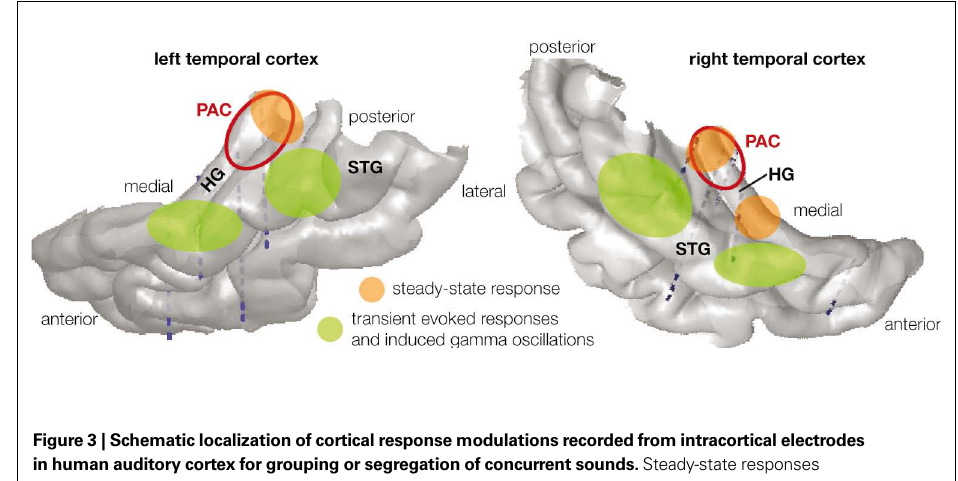
Figure 3 | Schematic localization of cortical response modulations recorded from intracortical electrodes in human auditory cortex for grouping or segregation of concurrent sounds. Steady-state responses were found larger when one sound rather than two was perceived in Heschl’s gyri. Transient evoked responses and induced gamma oscillations were found larger when one sound rather than two was perceived in secondary auditory areas in the superior temporal gyrus. PAC: primary auditory cortex (red circles), HG: Heschl’s gyrus, STG: superior temporal